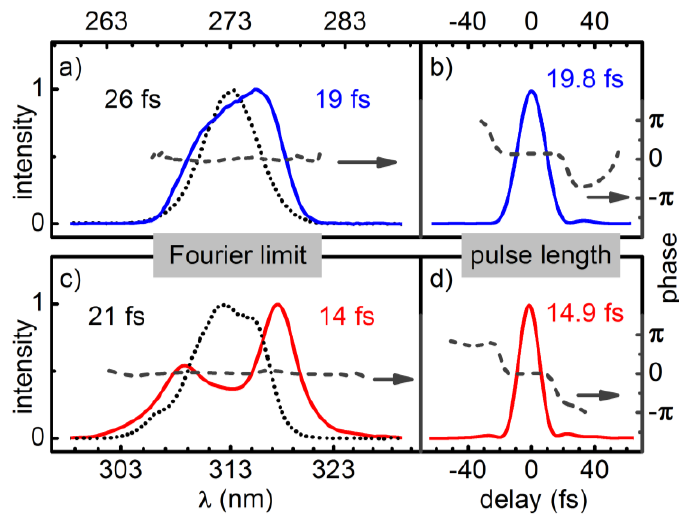
Figure 6. Pulse compression of sub-30 fs UV pulses generated by SHG ( a , b ) and SFG ( c , d ) of visible noncollinear parametric amplifier (NOPA) pulses by SPM broadening in a 2 mm ( a , b ) or 1 mm ( c , d ) CaF crystal. Dotted lines: input pulses; solid lines: spectrally 2 broadened pulses. Compression to a flat spectral and temporal phase (dashed lines) was achieved by the use of an acousto-optic pulse shaper and measured by a